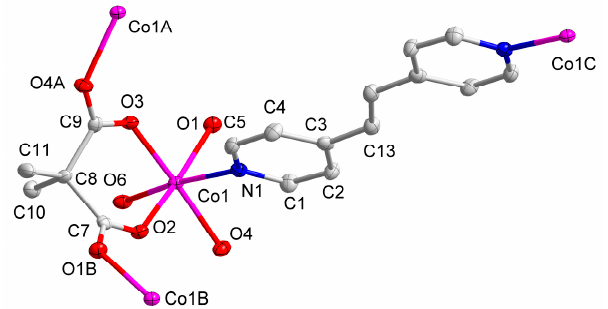
Figure 1. The metal coordination environments of compound 1 . The H atoms have been omitted for clarity. [Symmetry code: ( A ) − 0.5 + x, 1.5 − y, 0.5 + z; ( B ) 0.5 + x, 1.5 − y, 0.5 + z; ( C ) 1 − x, 2 − y, 3 − z].